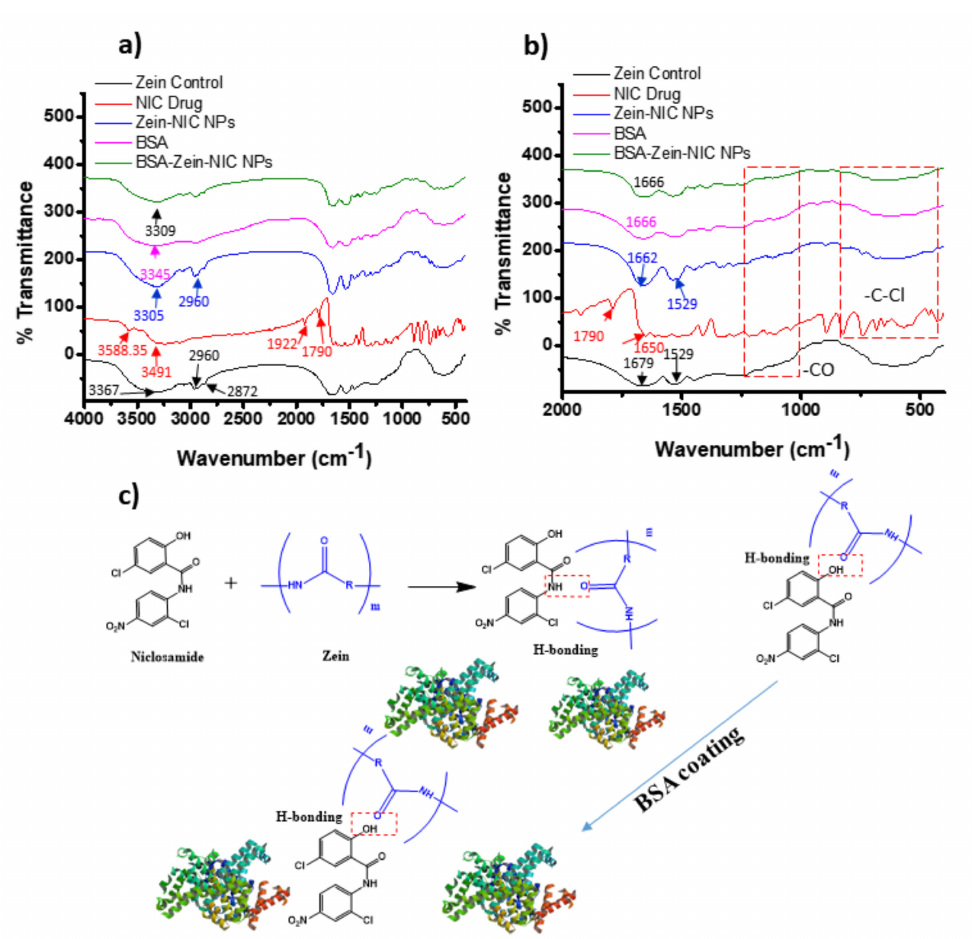
Figure 1. FT-IR analysis for Zein, NIC, Zein-NIC NPs, BSA, and BSA-Zein-NIC NPs: ( a ) full spectrum (4000 to 400 cm − 1 ) and ( b ) carbonyl region from 500 to 200 cm − 1 ; ( c ) possible interaction between BSA, Zein, and NIC in the final BSA-Zein-NIC